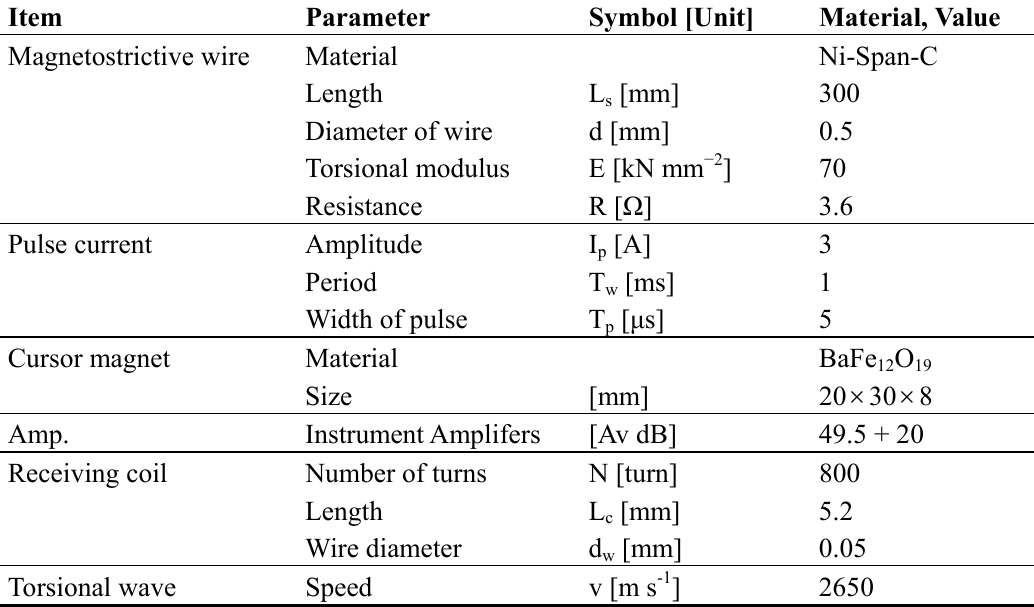
Table 1. Experimental conditions for